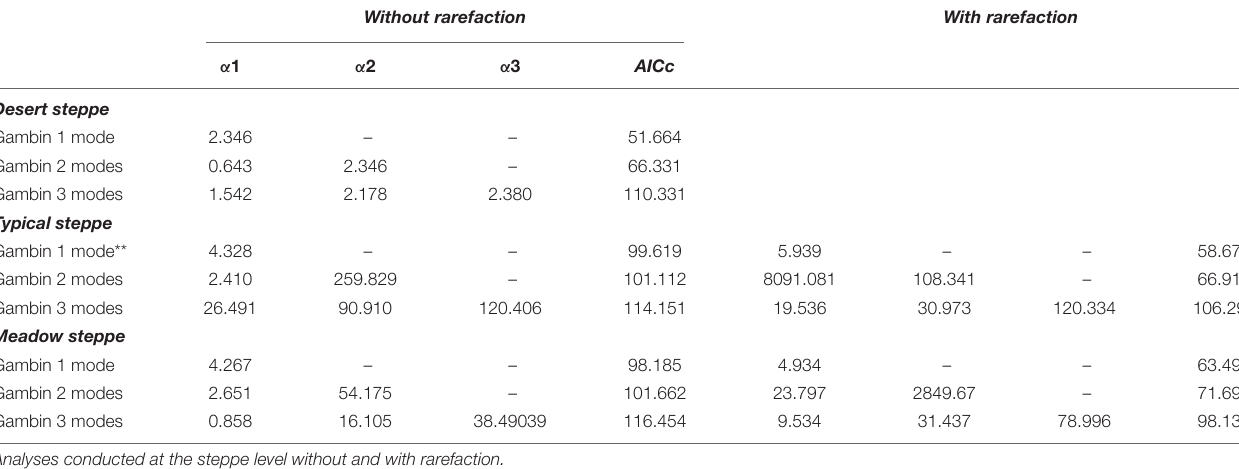
TABLE 4 | Values of gambin α and model’s corrected Akaike Information Criterion (AICc) for species abundance distributions of carabid beetles in various types of Chinese steppes. Without rarefaction With rarefaction